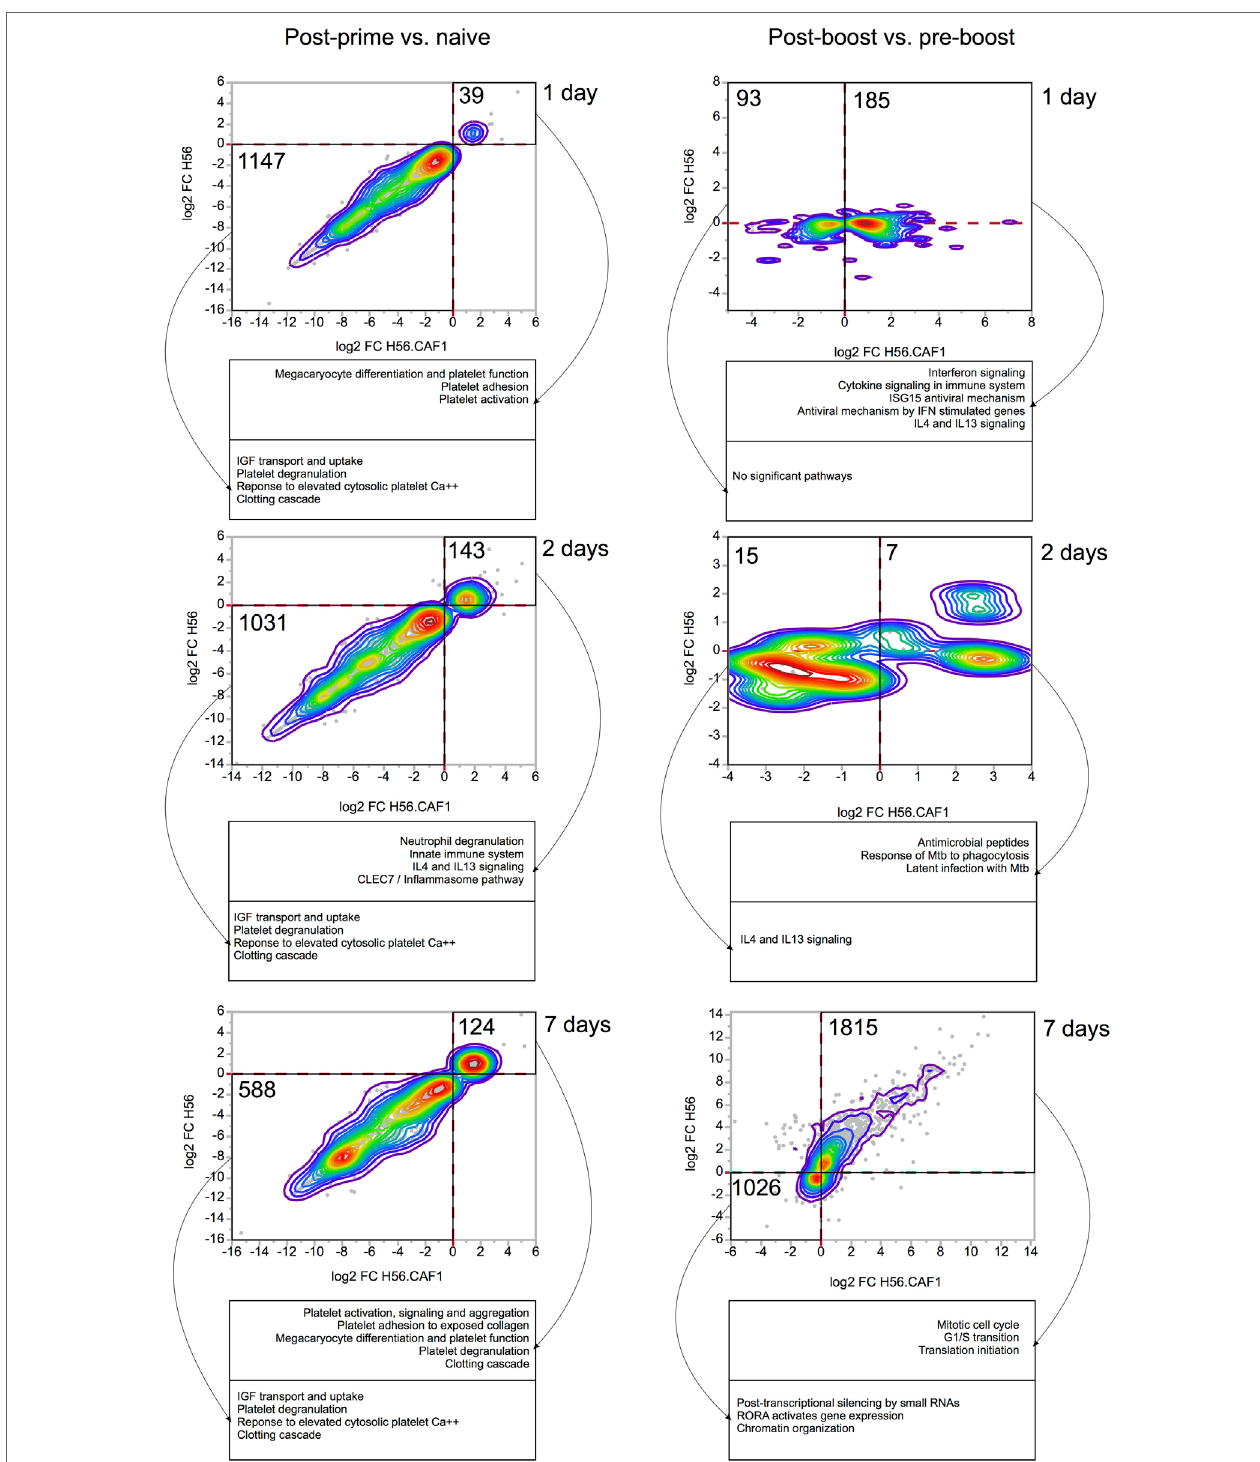
FigUre 3 | Comparisons of gene expression changes elicited by H56 and H56 + CAF01 vaccine formulations. Each bivariate plot illustrates the comparison at one time point, as indicated. For the post-prime time points, the comparisons are represented relative to the naïve baseline. For post-boost time points, the baseline is the pre-boost time point. Axes represent log 2 of baseline-normalized expression values. Each dot represents a gene, and colored lines indicate the density of dots on the graph. Only genes significantly regulated (FDR < 0.05) by at least one vaccine were included and plotted. Numbers indicate the number of genes included in areas indicated by solid black lines. Dashed red lines indicate 0 values (no change in gene expression). Functional analysis was done using Reactome database, and representative significantly enriched pathways are included in captions under each